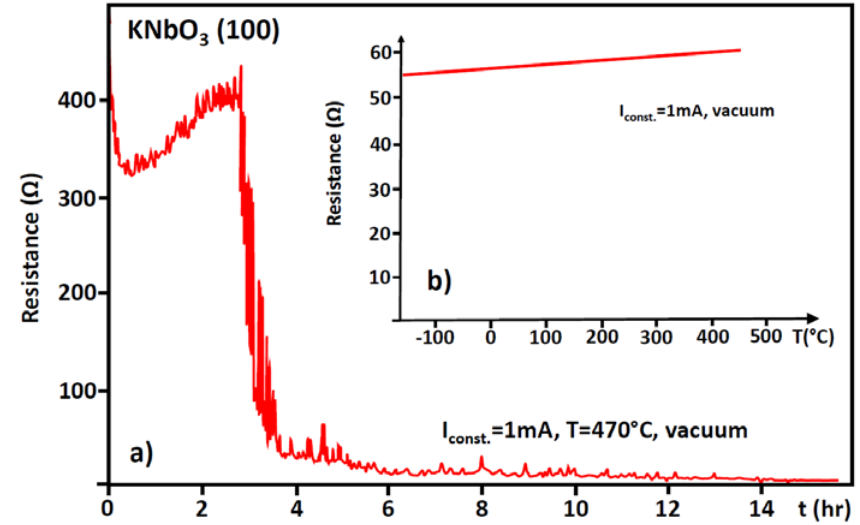
Figure 47. Electroreduction of KNbO3 single crystal ( a ), by electrical polarization using a constant current in the paraelectrical phase (T = 470 °C, vacuum)). Inset ( b ) shows the typical metallic temperature dependence of the resistivity for the completely reduced sample. Adapted from [59].